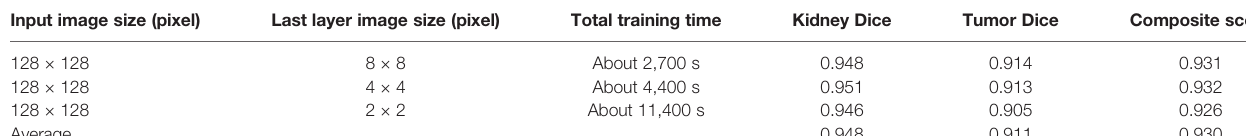
TABLE 4 | Fine segmentation based on FR2PAttU-Net model [parallel convolutions (convolution kernel = 3 × 3 and 5 × 5)].